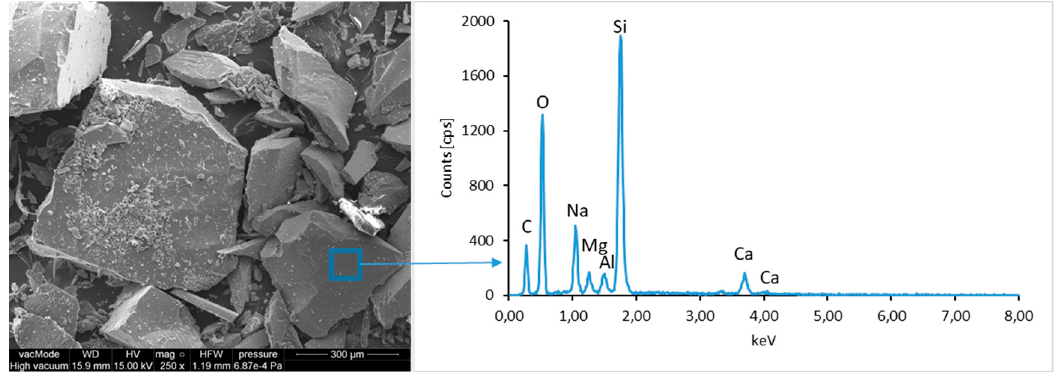
Figure 9. Scanning electron microscopy (SEM) micro-structure of an LCD panel and results of elemental analysis in energy dispersive spectroscopy (EDS) micro-area.